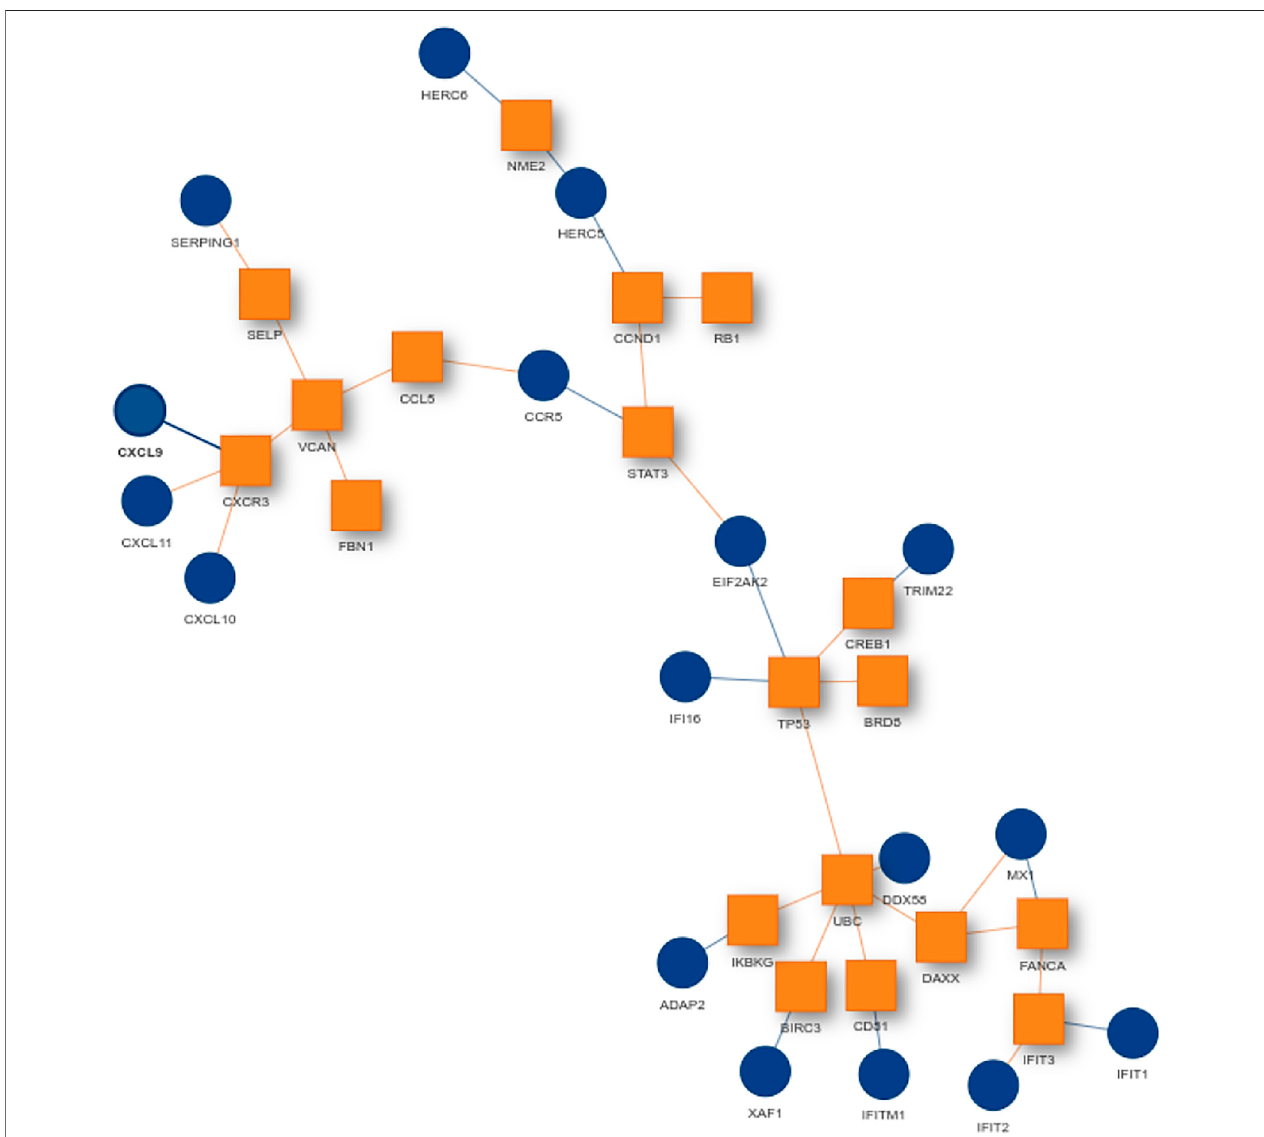
FIGURE4| SARS-CoV-2networkfromthecon fi guration L (cid:1) 220and K (cid:1) 20.Many genesofthenetworkareknowntobeimportantplayers inthehumanimmune response. Exception nodes are visualized as orange squares and signi fi cant nodes as blue circles.